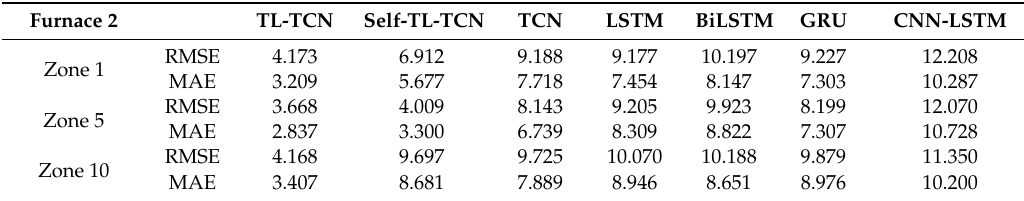
Table 17. The prediction results of each model in heating furnace 2.